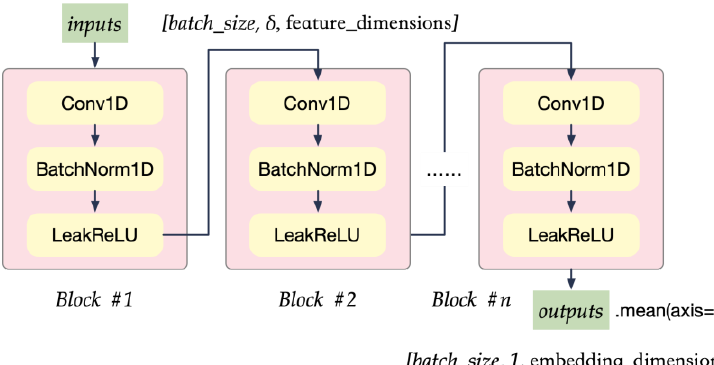
Figure 5. CNN blocks for KPIs sequences. Each block contains 1D convolutional neural network layers followed by batch normalization layers and LeakReLU as the activation functions.